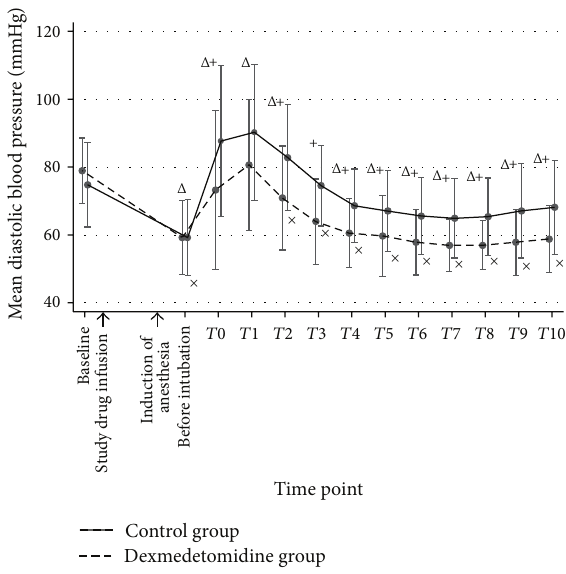
Figure 2: A line graph demonstrated the mean SBP and their stan- dard deviation comparing groups at different time points. Baseline refers to the point of time before the study drug is administered. Before intubation refers the point of time after anesthetic induction just before DLT intubation. T0 is the period during intubation. T1– T10 refer the points of time as minutes after intubation. SBP: systolic blood pressure. + P value < 0.05 compared between groups. Δ P value < 0.05, significant difference compared with baseline in the control group. × P value < 0.05,significantdifferencecomparedwithbaseline in the dexmedetomidine group.